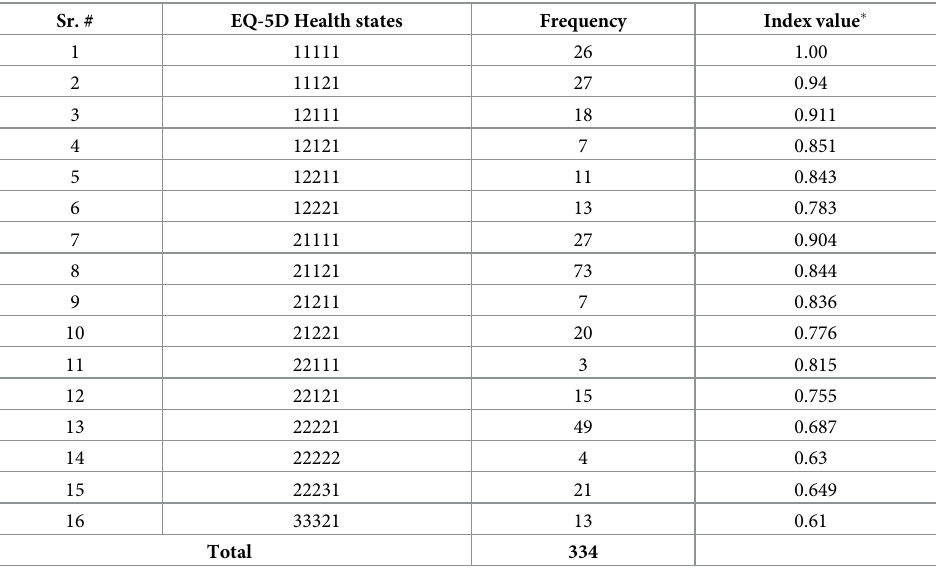
� Index values were obtained by UK based value